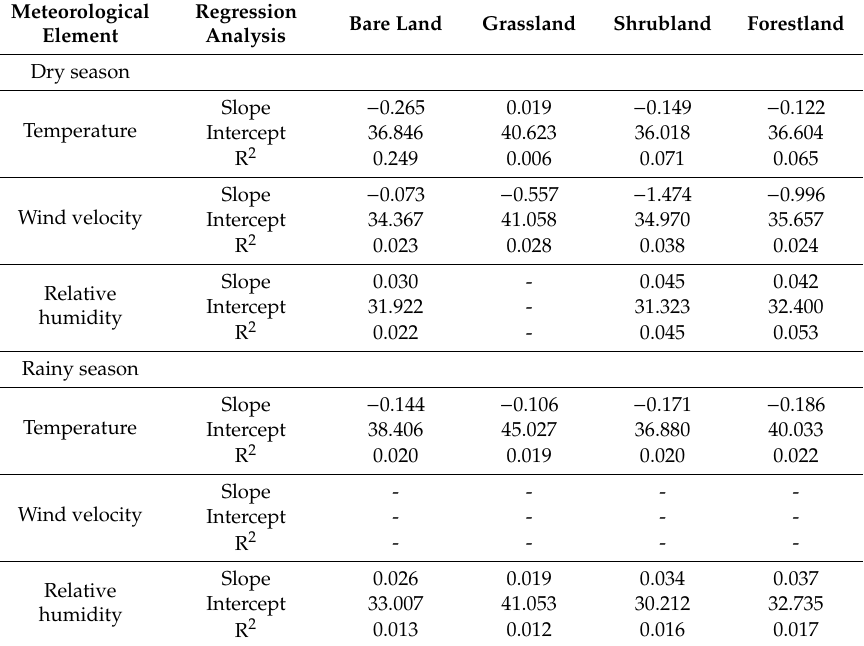
Table 14. Results of the regression analysis between volumetric soil moisture content and temperature, wind velocity, and relative humidity in a period without